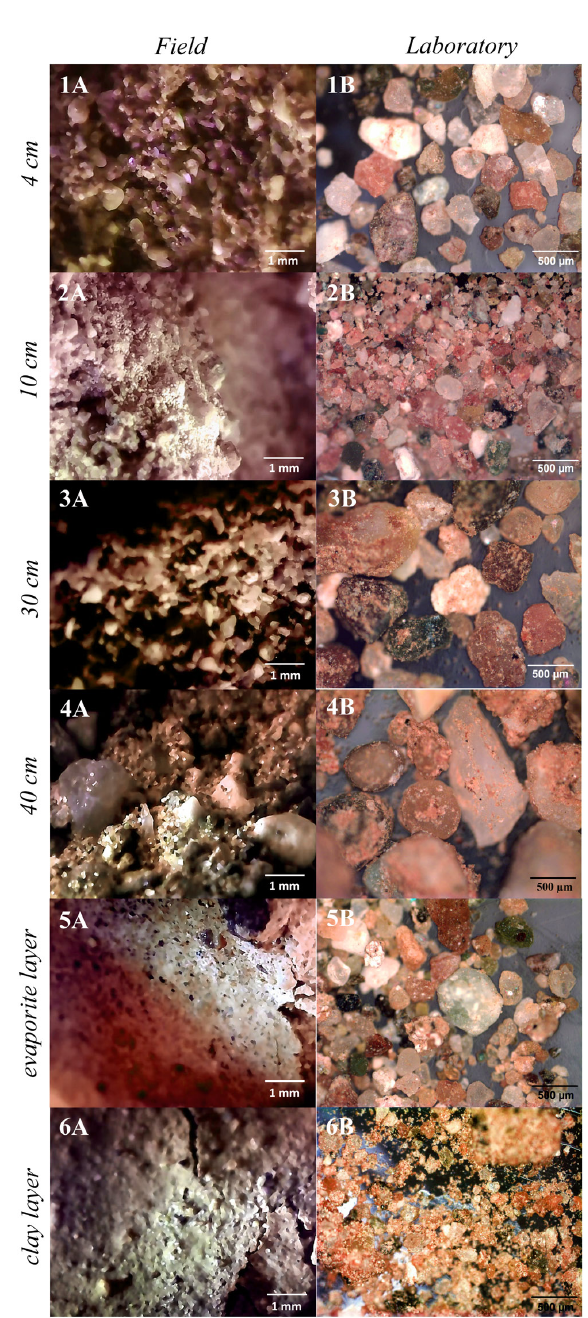
Figure 8. Images recorded by the borehole-wall camera in the field (left column) and in the laboratory (right column) from the same layer (in the same row) at the 0601 sampling site in the wadi area. Note the different scale between the left and the right